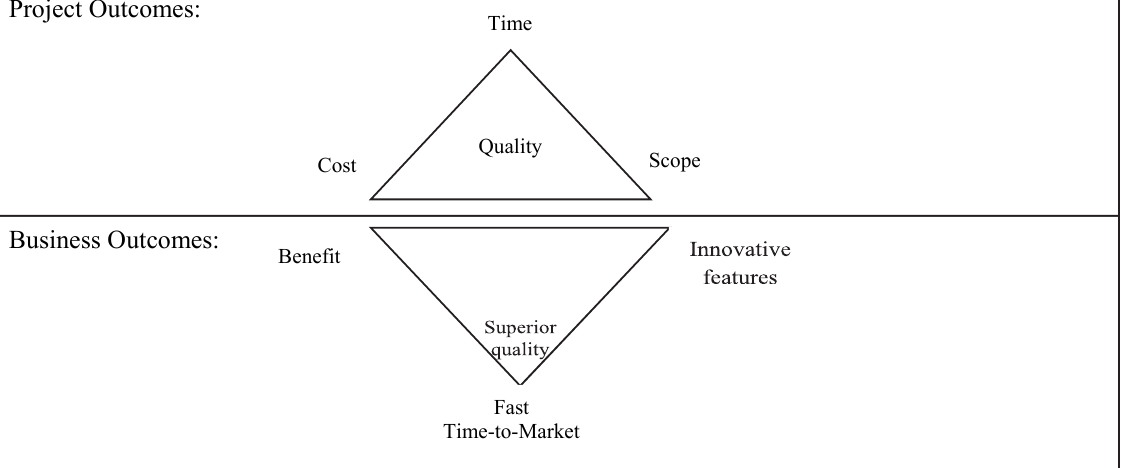
Fig. 1. Linking project outcomes to business outcomes